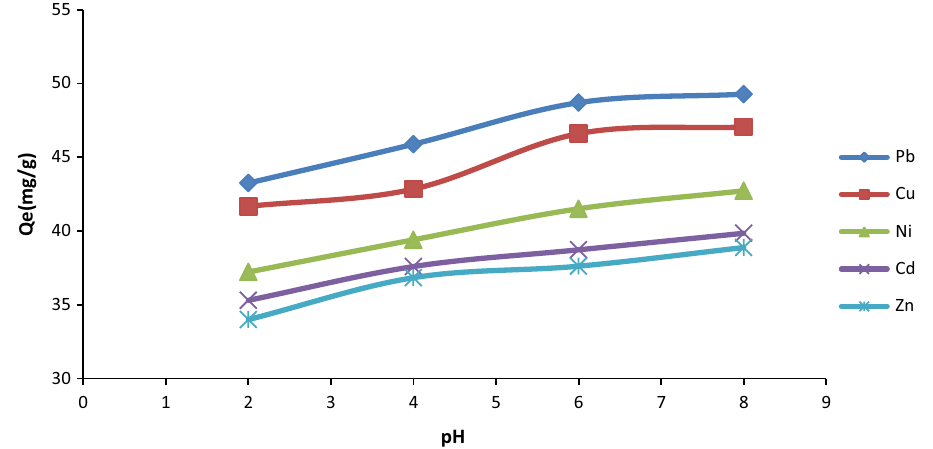
Fig. 2 SEM image of the chitin Fig. 3 Effect of pH on the